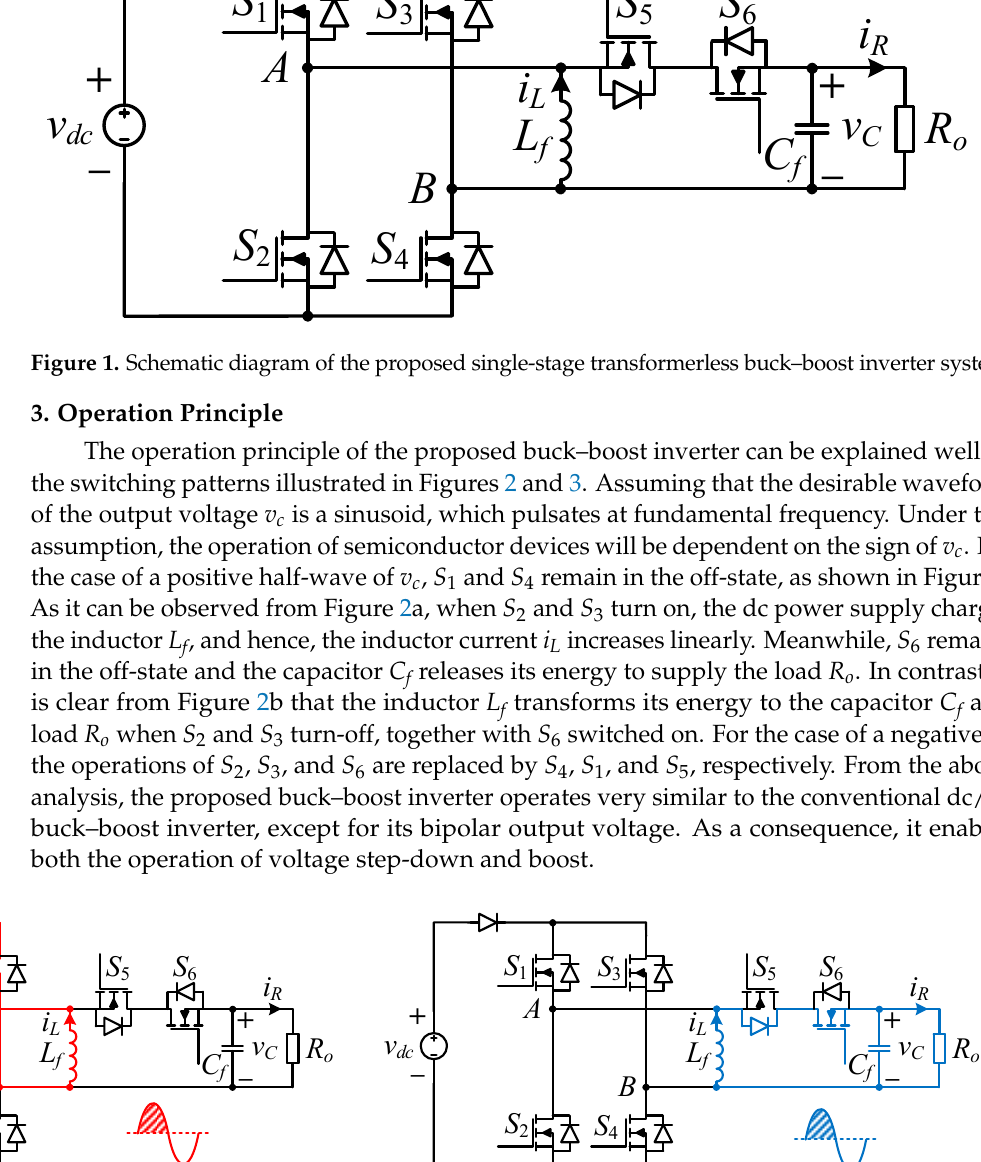
Figure 1. Schematic diagram of the proposed single-stage transformerless buck–boost inverter sys- tem.